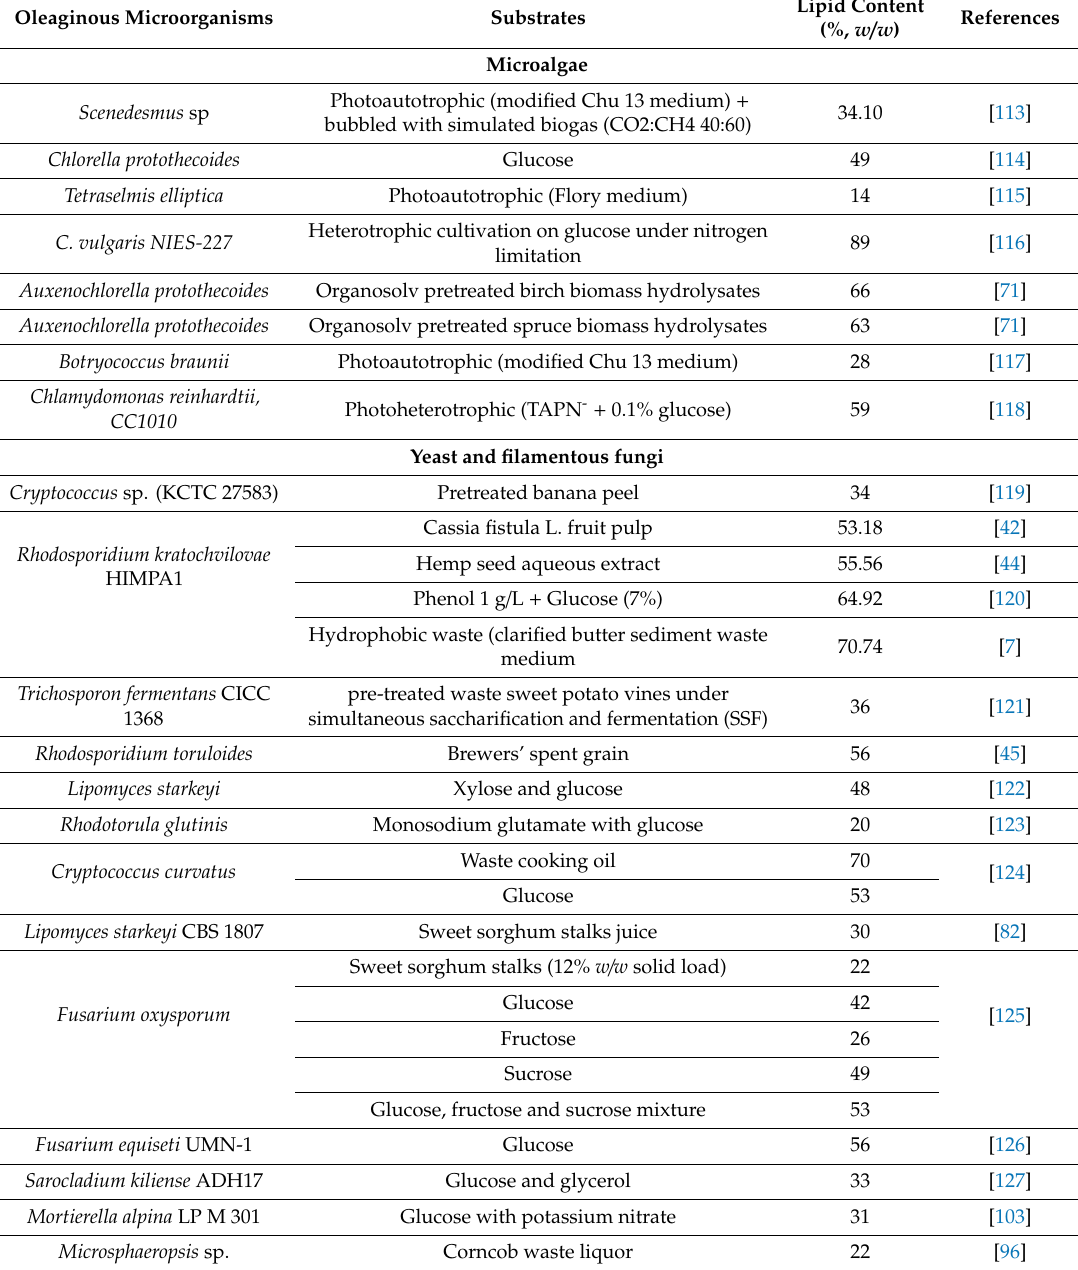
Table 1. A list of oleaginous microorganisms cultivated on various sources and their lipid content. Oleaginous Microorganisms Substrates